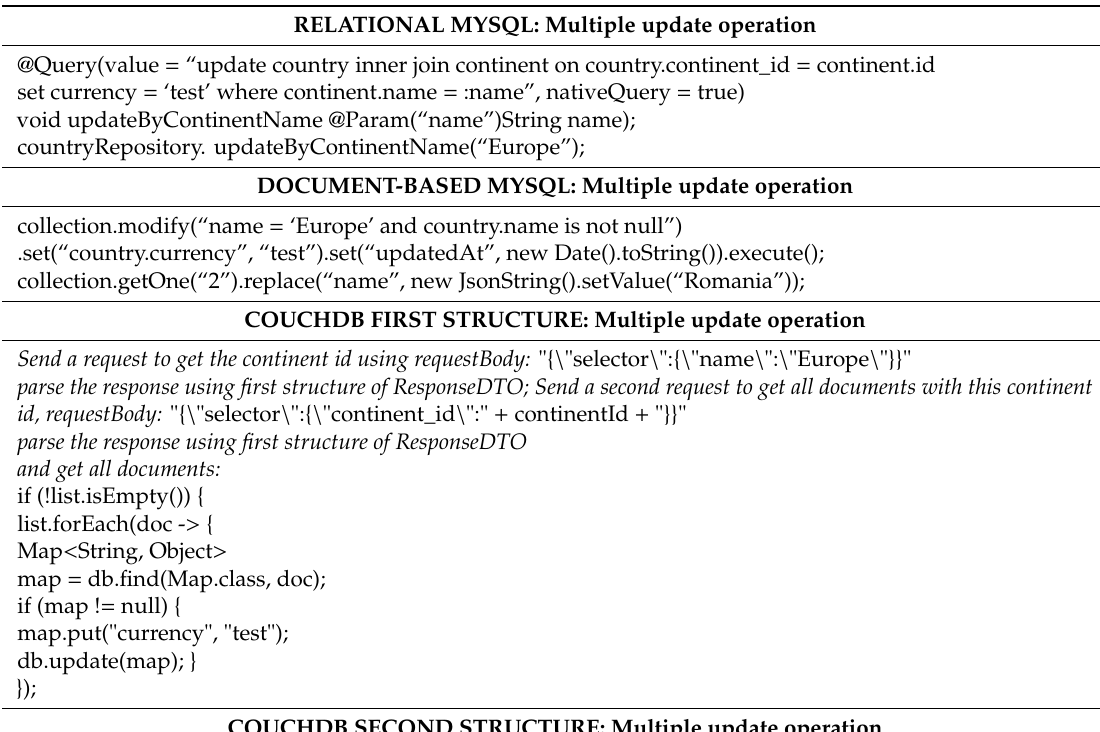
Table 3. Multiple update